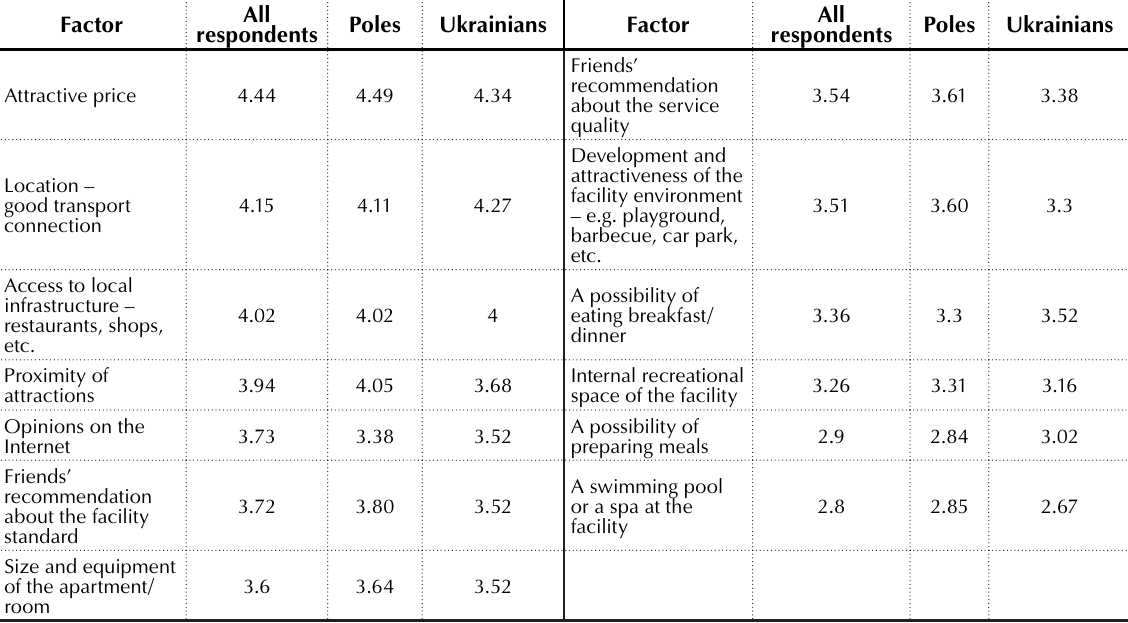
Table 4. Determinants of selecting a facility offering accommodation services